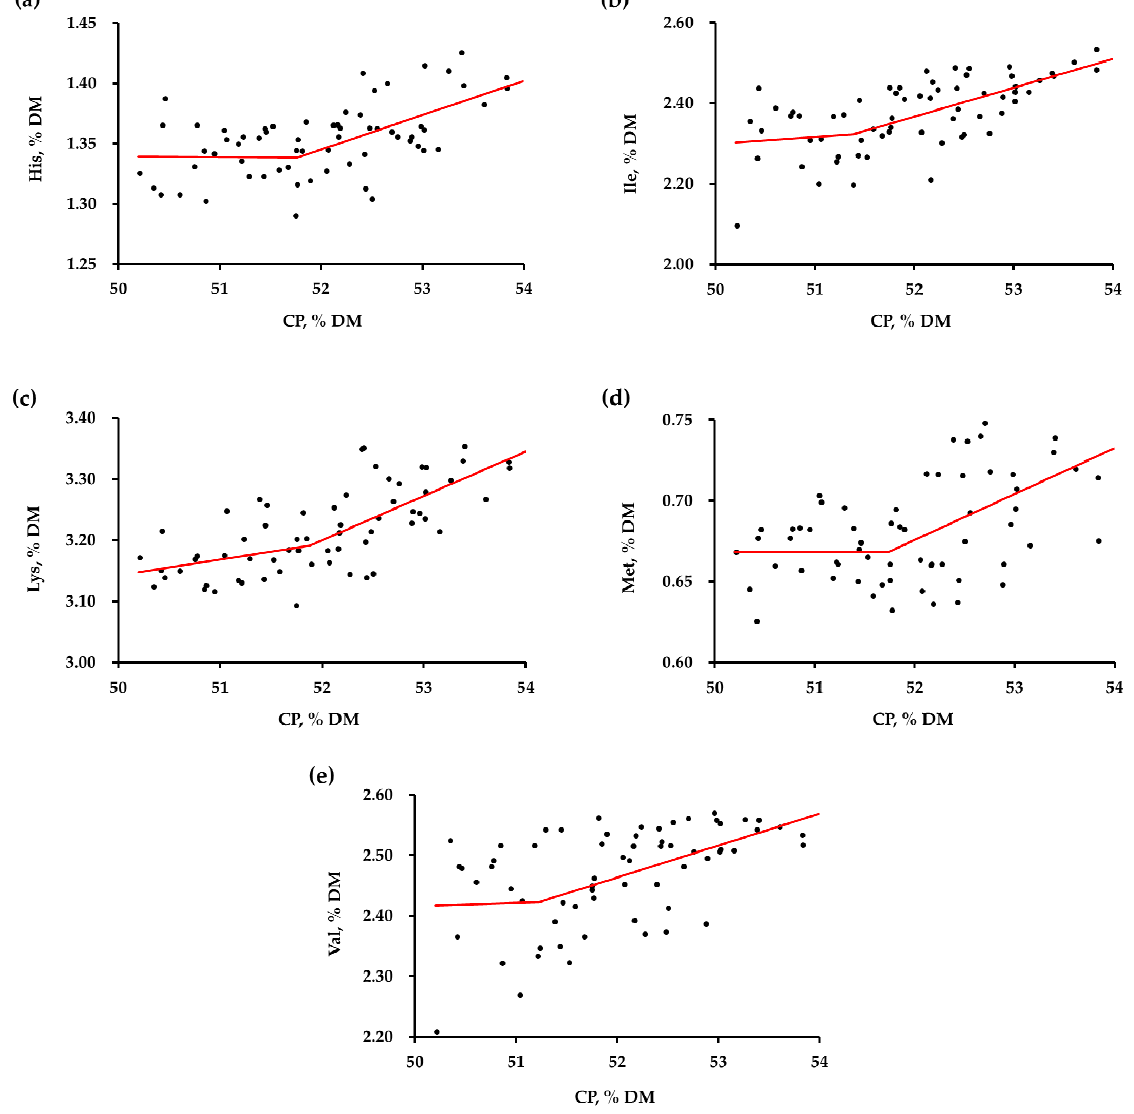
Figure 1. Prediction equations for His, Ile, Lys, Met, and Val (% dry mater (DM)) using crude protein (% DM) in soybean meal ( n = 64). Linear broken-line models represented by solid lines indicate: ( a ) His = 1.34 + 0.0006 × (51.76 − CP) where CP < 51.76 and His = 1.34 + 0.028 × (CP − 51.76) where CP > 51.76 (R 2 = 0.32, root mean square error (RMSE) = 0.025, and p < 0.001); ( b ) Ile = 2.32 – 0.018 × (51.39 − CP) where CP < 51.39 and Ile = 2.32 + 0.072 × (CP − 51.39) where CP > 51.39 (R 2 = 0.40, RMSE = 0.069, and p < 0.001); ( c ) Lys = 3.19 − 0.026 × (51.88 − CP) where CP < 51.88 and Lys = 3.19 + 0.072 × (CP − 51.88) where CP > 51.88 (R 2 = 0.51, RMSE = 0.049, and p < 0.001); ( d ) Met = 0.67 − 0.0001 × (51.73 − CP) where CP < 51.73 and Met = 0.67 + 0.028 × (CP − 51.73) where CP > 51.73 (R 2 = 0.27, RMSE = 0.030, and p < 0.001); ( e ) Val = 2.42 − 0.005 × (51.23 − CP) where CP < 51.23 and Val = 2.42 + 0.053 × (CP − 51.23) where CP > 51.23 (R 2 = 0.26, RMSE = 0.072, and p < 0.001).